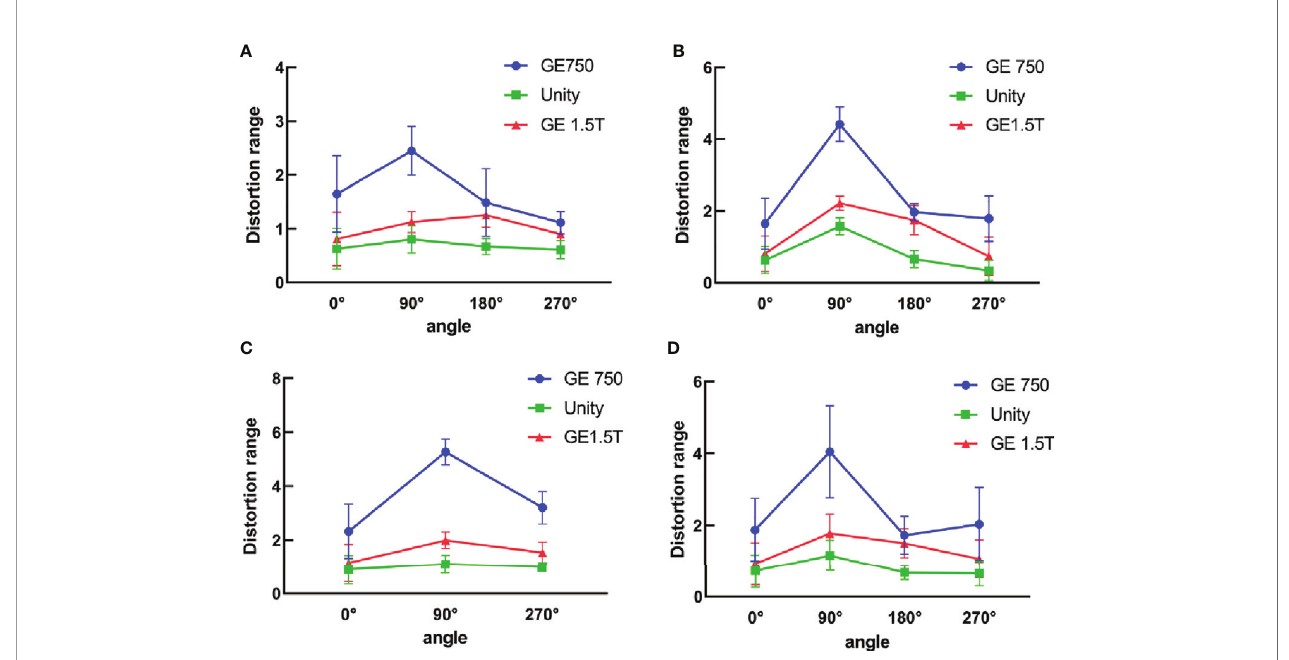
FIGURE 6 | 3D distortion between GE750, Unity, and GE 1.5T for the different distance ranges. (A) 5 cm from the central point, (B) 10 cm from the central point, (C) 15 cm from the central point, and (D) all the distortion points within 15 cm.